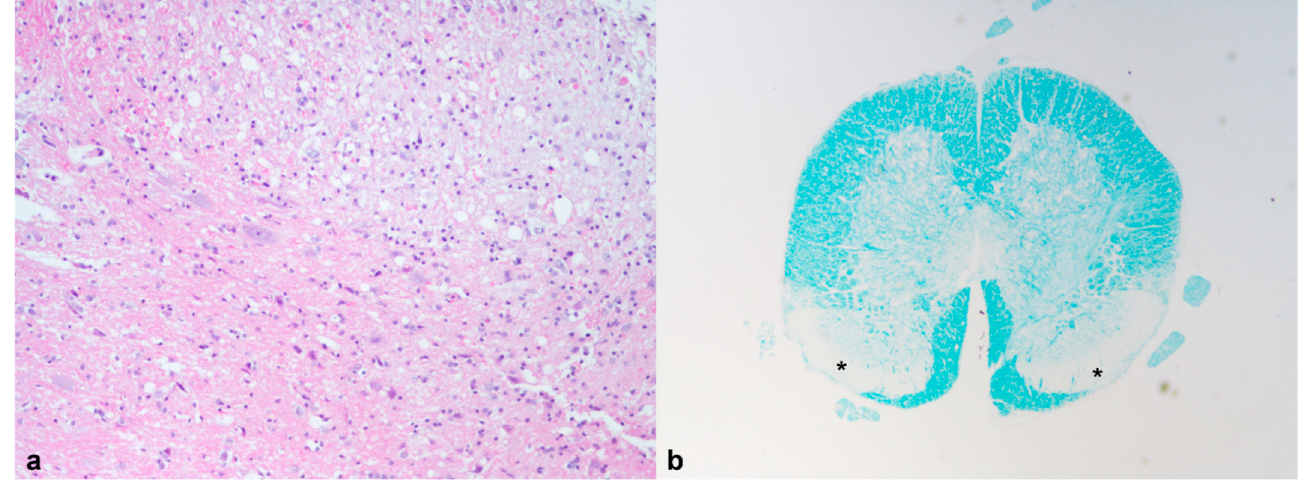
Figure 8. African pygmy hedgehog, Medulla oblongata. Case 1, Wobbly hedgehog syndrome. ( a ) Note the white matter spongiosis in the medulla oblongata (HE, 100×); ( b ) Bilateral pale areas (*), representing myelin loss, in the lower tracts of the medulla oblongata (Luxol fast blue, 20×).